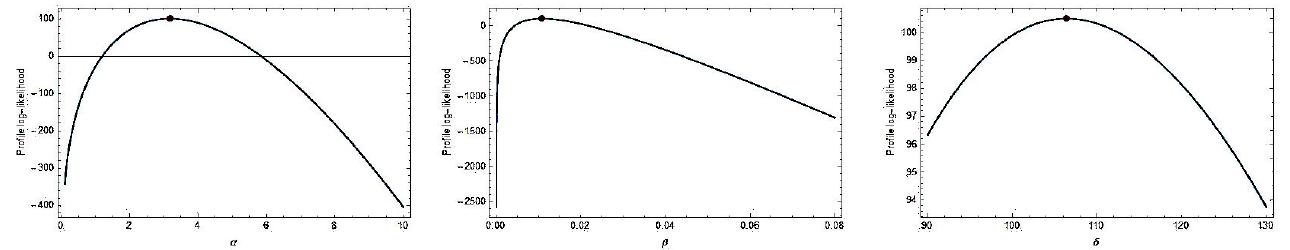
Figure 11. Behavior of log-likelihood function with 3PB model parameters for the stress-rupture data set.